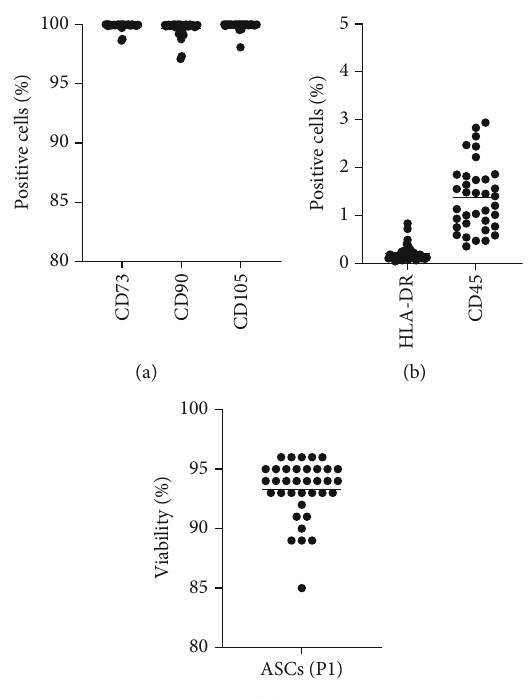
Figure 3: Identity, purity, and viability. (a) % expression of positive surface markers. (b) % expression of negative surface markers. (c) Viability of CSCC_ASC ( n = 36 ). The line represents the mean